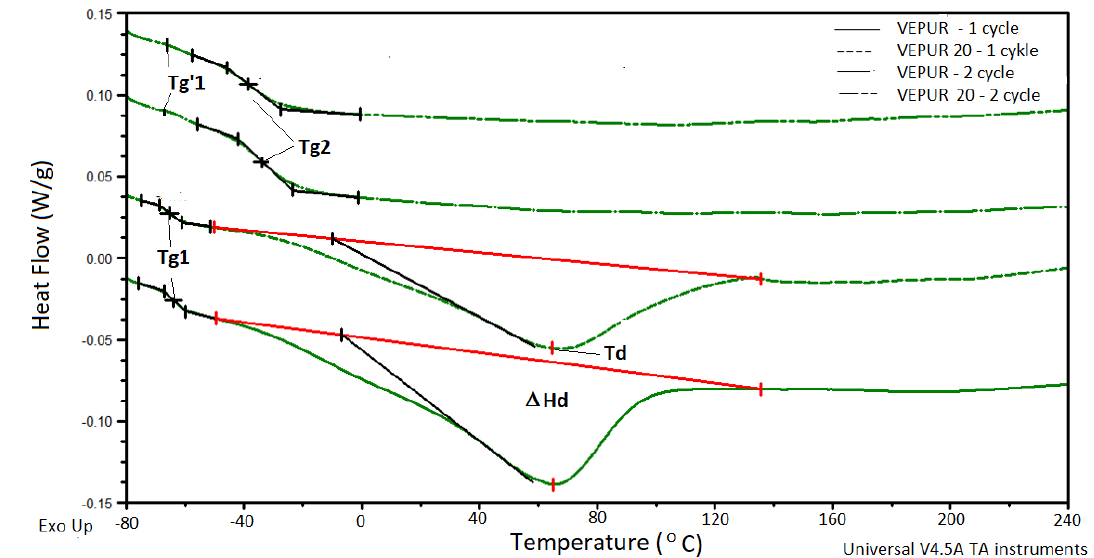
Figure 14. Comparison of thermograms from differential scanning calorimetry (DSC) analysis of the first and second cycle of heating. Table 9. Results of the DSC analysis of the examined